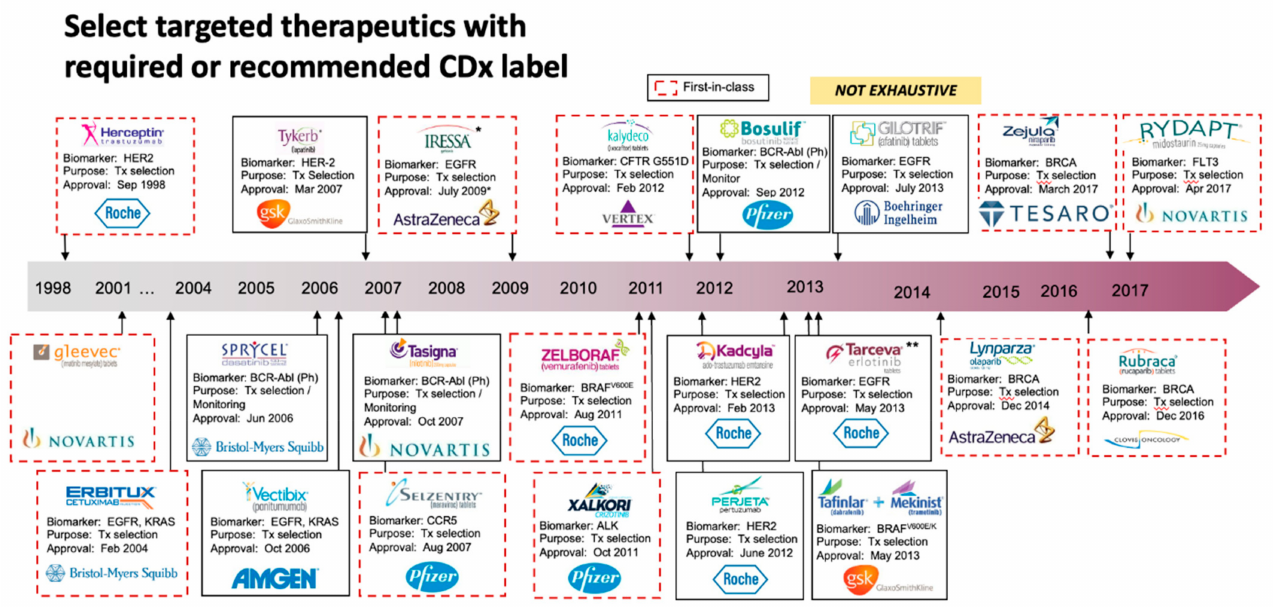
Figure 5. Overview of List of Approved Oncology CDx Tests on the Market. The first approved CDx was Herceptin ® which was introduced in early 1998 to treat breast cancer patients with HER-2/neu. The CDx tests are used precisely for specific therapies that inhibit signal transduction pathways by either inhibiting the intracellular tyrosine kinase activities using a small molecule or preventing ligand-induced receptor activation with a monoclonal